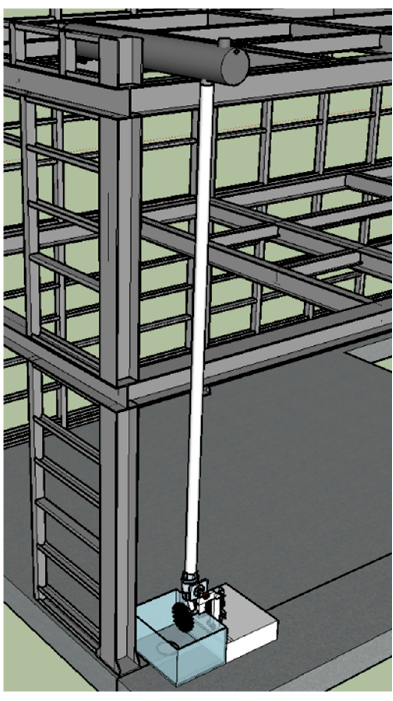
Figure 1. CAD 3D design of the structure for the energy recovery